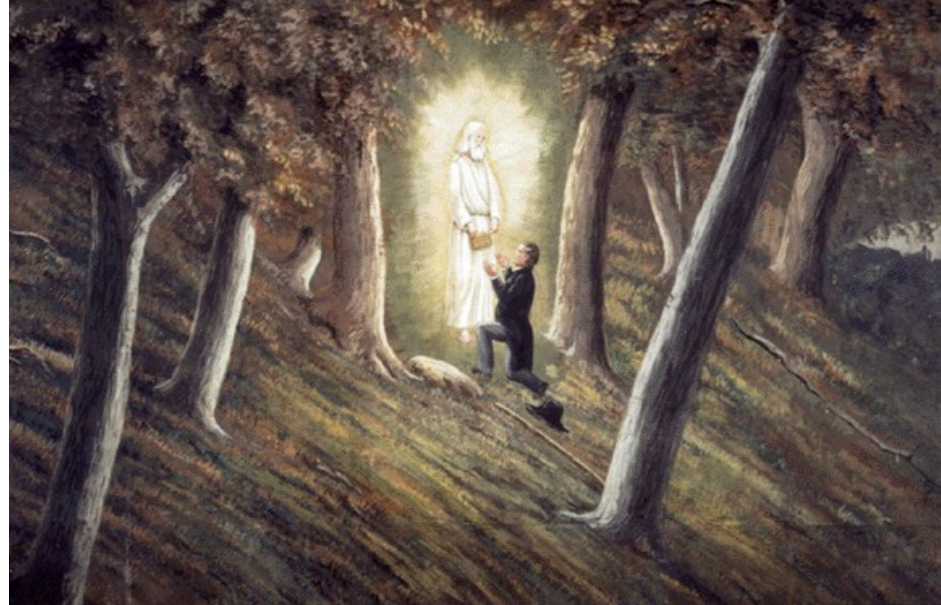
Figure 10. The Hill Cumorah by Carl Christian Anton Christensen 1878. Mural painting. Courtesy of Wikimedia Commons.